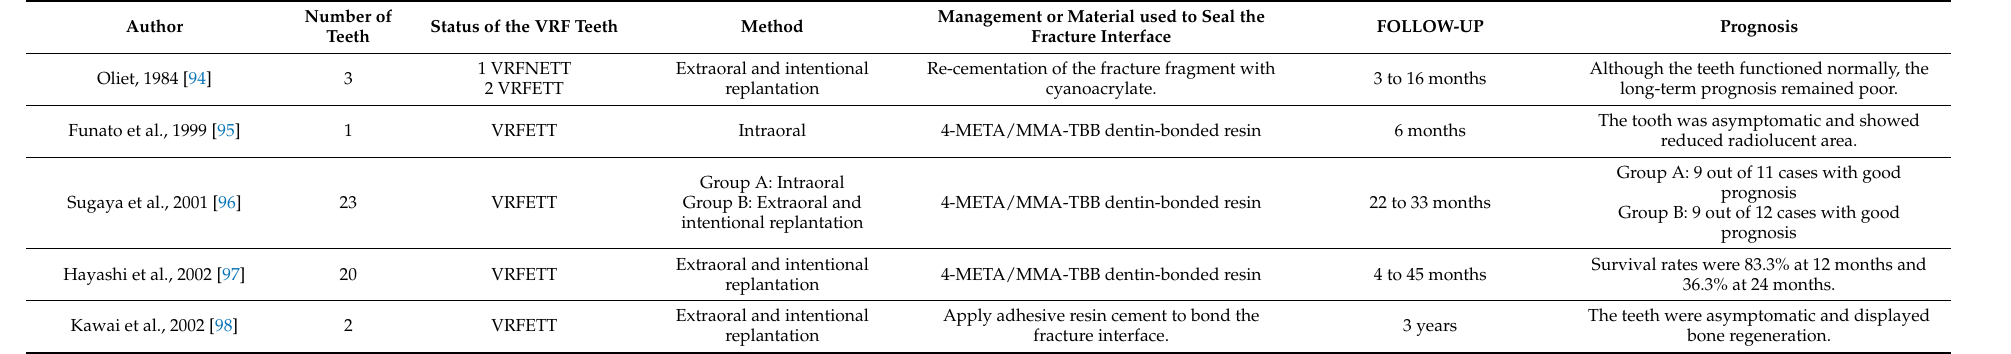
Table 5. Research regarding the re-cementation of VRFs with multiple adhesive